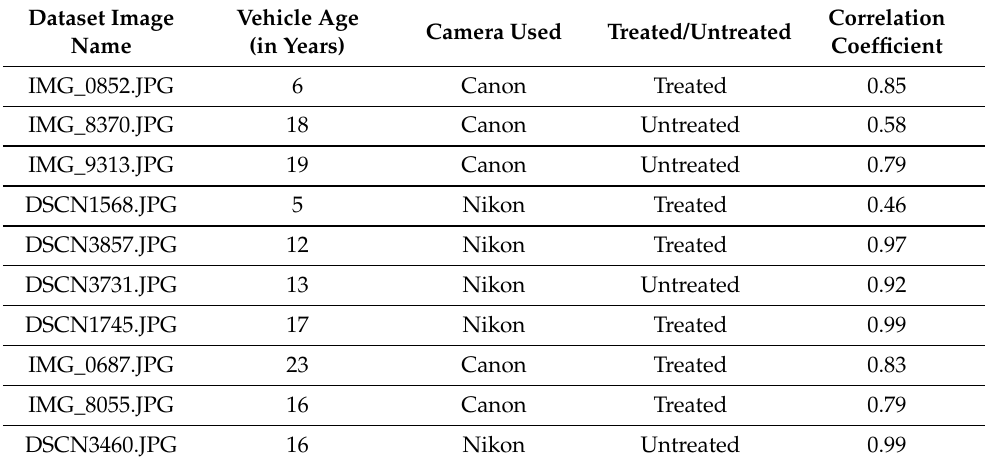
Table 1. Demonstration of correlation between original images and their respective corrosion detec- tion output